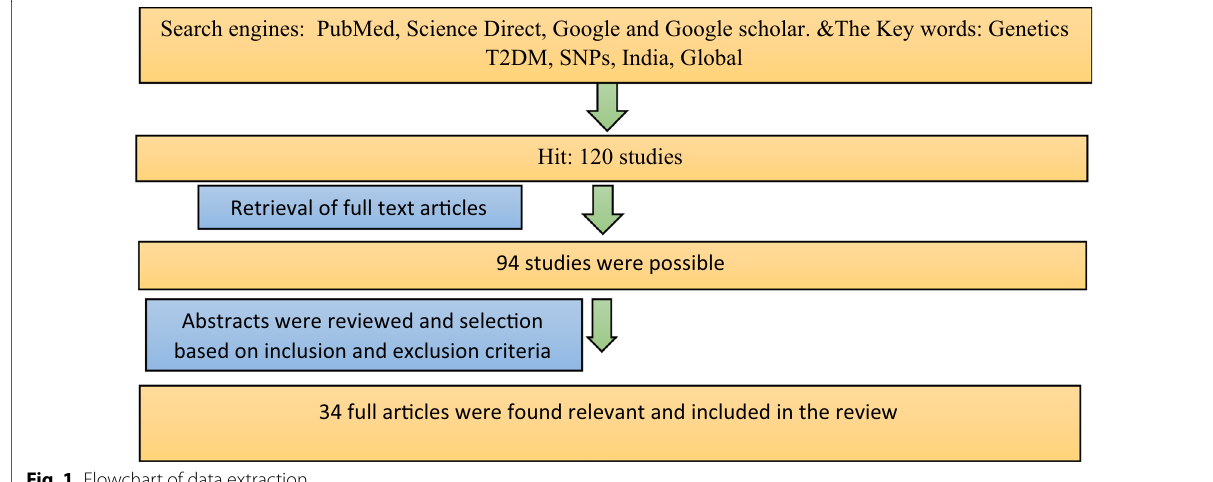
Fig. 1 Flowchart of data